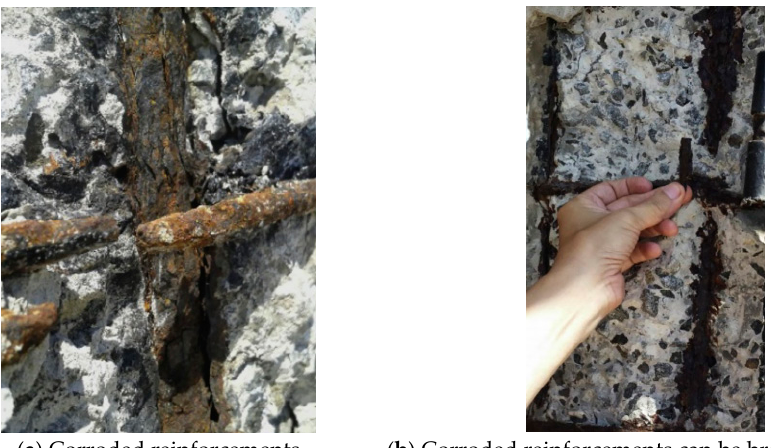
Figure 1. Collapsed building with a high degree of corrosion in the reinforcements [3]: ( a ) Corroded reinforcements; ( b ) Corroded reinforcements can be broken by hand.